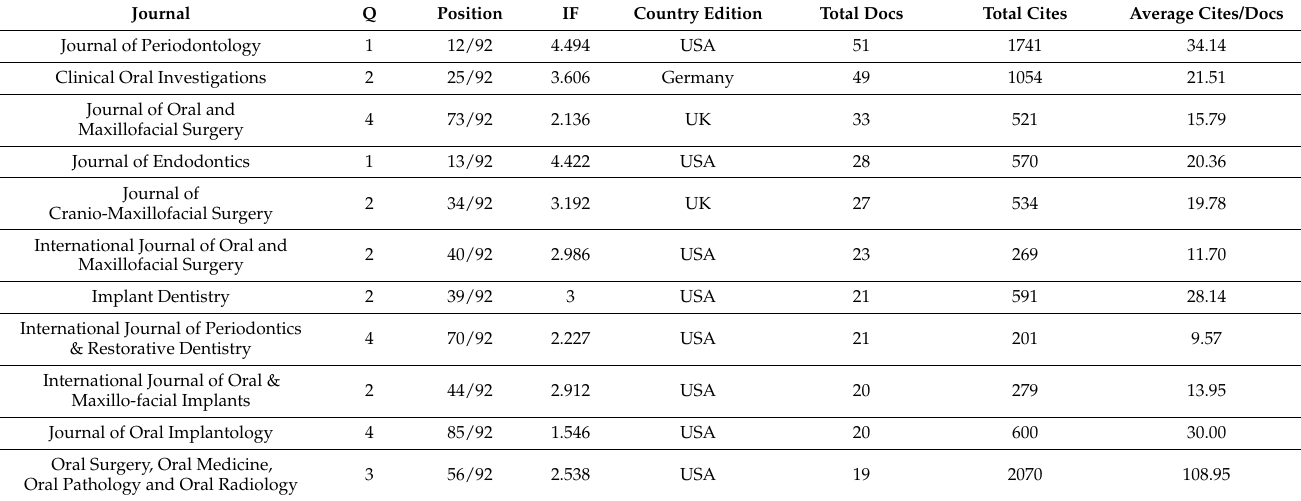
Table 1. Most productive journals with PRF related publications in WoS (from Journal Citation Reports TM 2021) (position in dentistry, oral surgery and